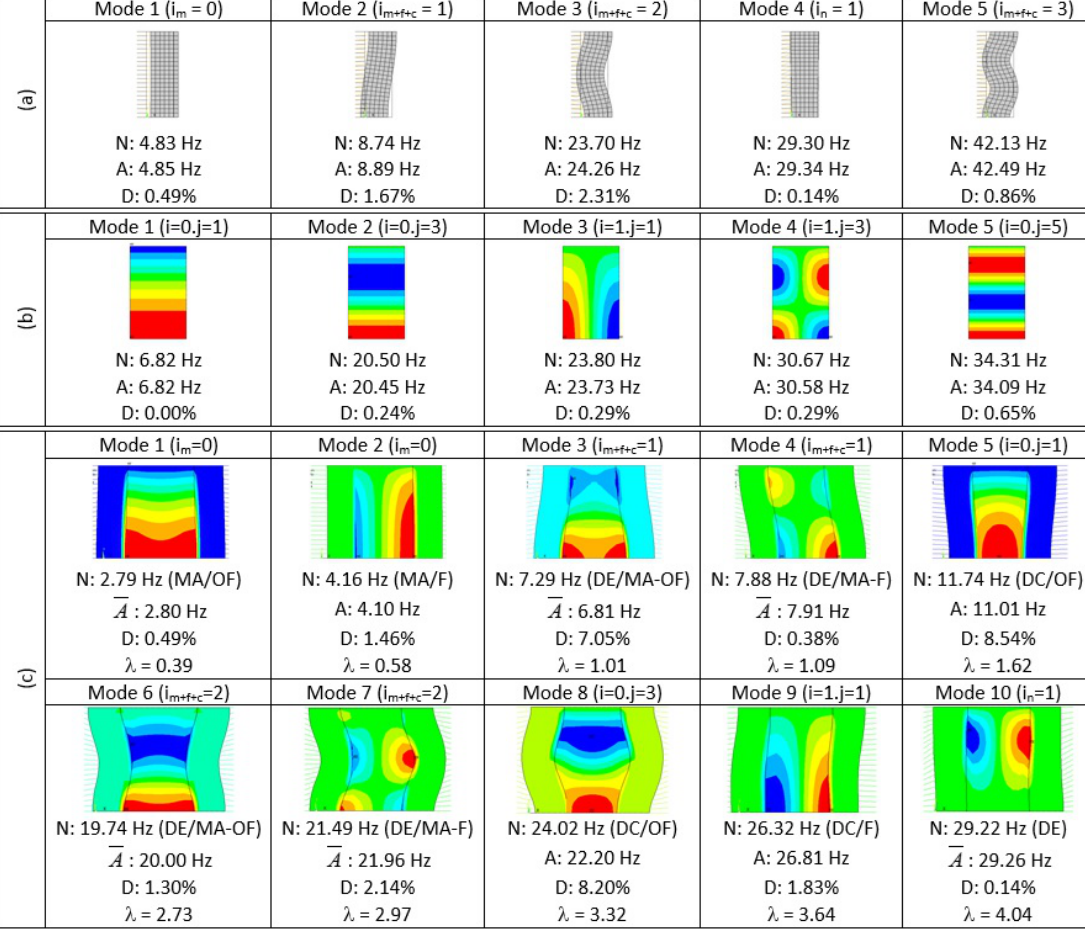
Figure 6. Natural numerical (N) and analytical (A) frequencies, in Hz, the percentage difference between the values (D) and the corresponding vibration modes of the 2D acoustic cavity piston case: (a) uncoupled structural system, (b) uncoupled fluid system and (c) coupled fluid- structure system. λ is the compressibility parameter. A is the coupled frequency obtained by the hybrid